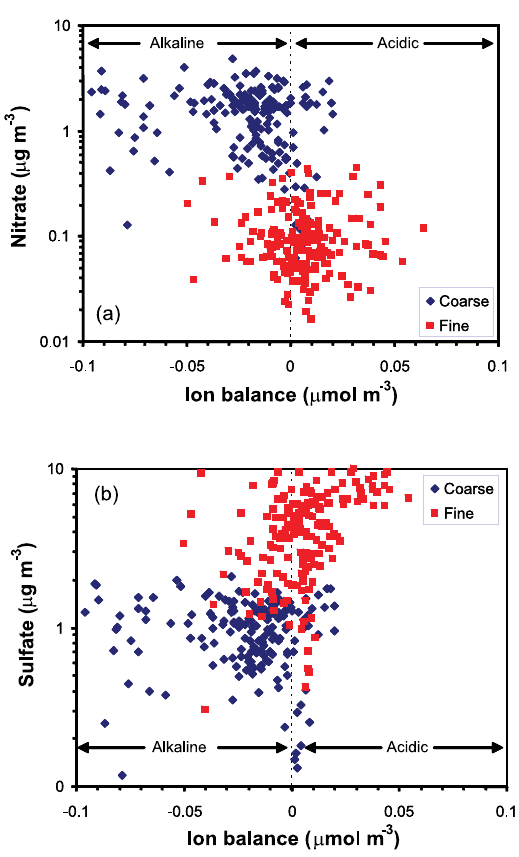
Fig. 1. Distributions of key acidic aerosol species in the Finokalia data set. Shown are the concentrations of (a) nitrate and (b) sulfate against the “ion balance”, I b , calculated as I b =2[SO 4 ] + [H 2 PO 4 ] + [NO 3 ] + [Cl] − 2[Ca] − [NH 4 ] − [Na] − 2[Mg] − [K], where “[ X ]” represents the concentration of species “ X ” in the aerosol sample, in molm − 3 air. Data for coarse and fine aerosol fractions are presented as blue and magenta symbols, respectively.